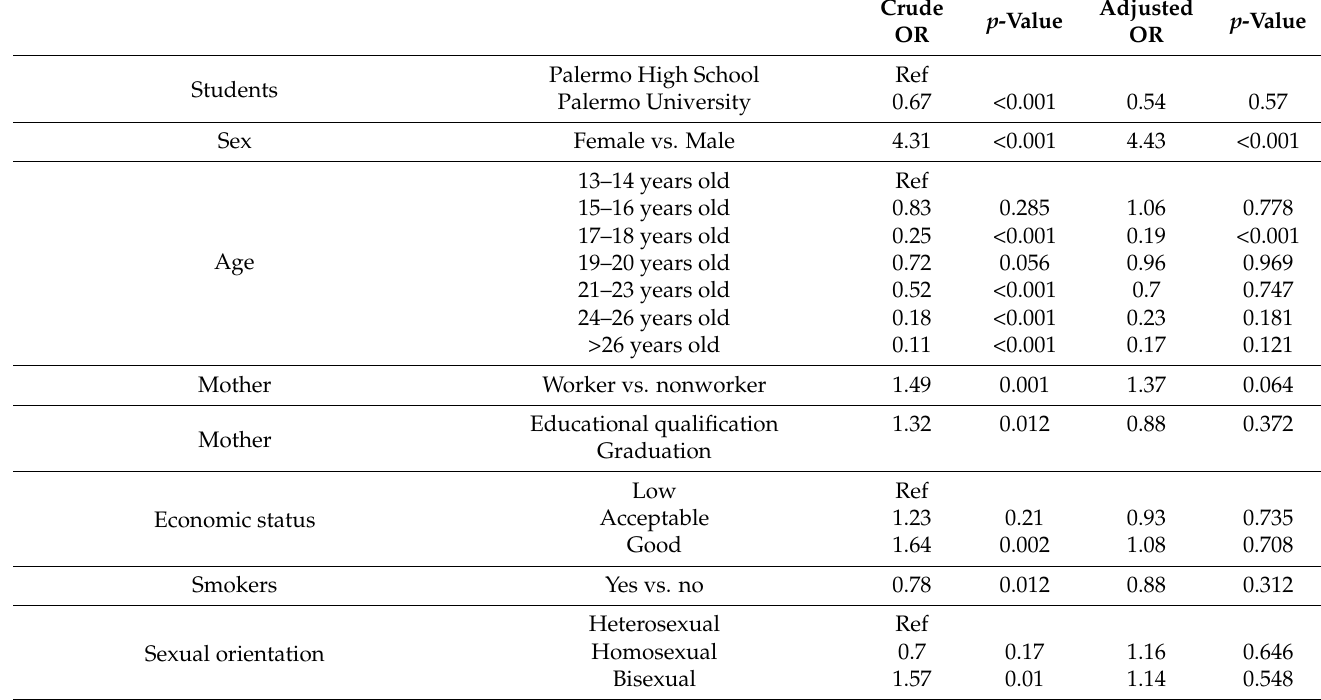
Table 4. Univariate and multivariate analysis of factors associated with HPV vaccination